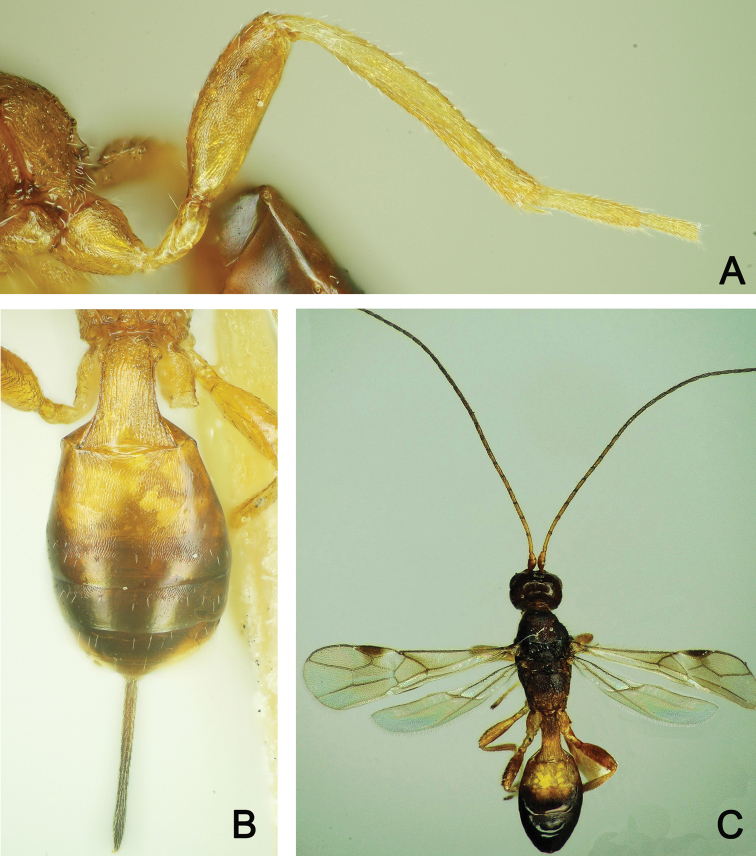
Spathius
brevicaudisA ♀, Left hind leg, lateral view B ♀, metasoma, dorsal view C ♂, habitus, dorsal view.